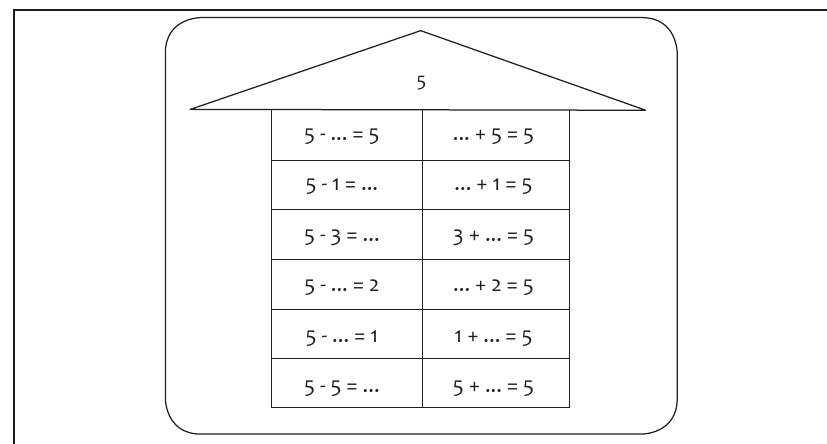
Figure 12: Inverse property of addition and subtraction operations These tasks can be completed by means of word problems, such as: ‘A woman has ten oranges. She shares some with her daughter. Now she has three oranges left. How many oranges did she give to her daughter?’ Low-performing children can go back to the part-part-whole blocks at any